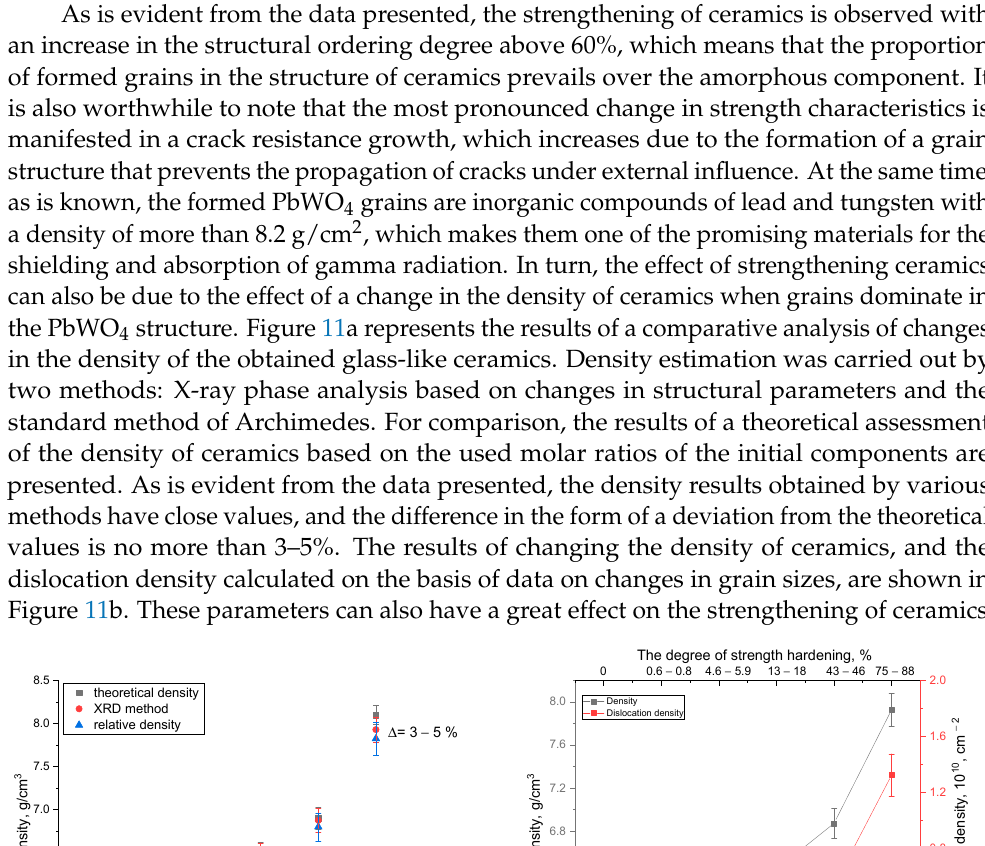
( b ) Figure 11. ( a ) The results of variations in the density of ceramics depending on the PbO dopant concentration; ( b ) Results of variations in density and dislocation density depending on the PbO dopant concentration.